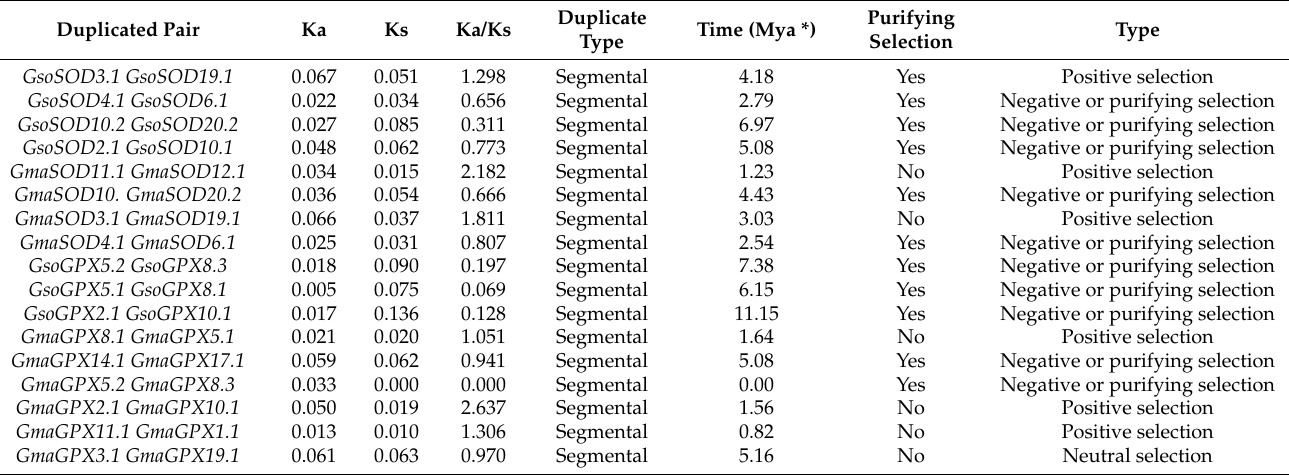
Table 2. Ka/Ks analysis and estimated divergence time for the duplicated SOD and GPX genes in paralogs of G. max and G. soja